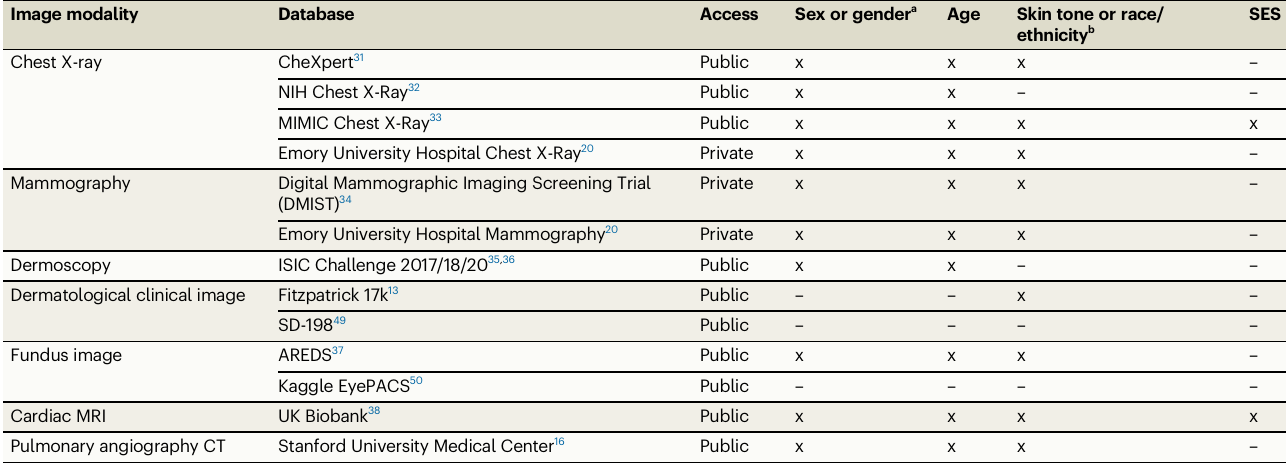
Table 1 | Databases commonly used in fairness in MIC